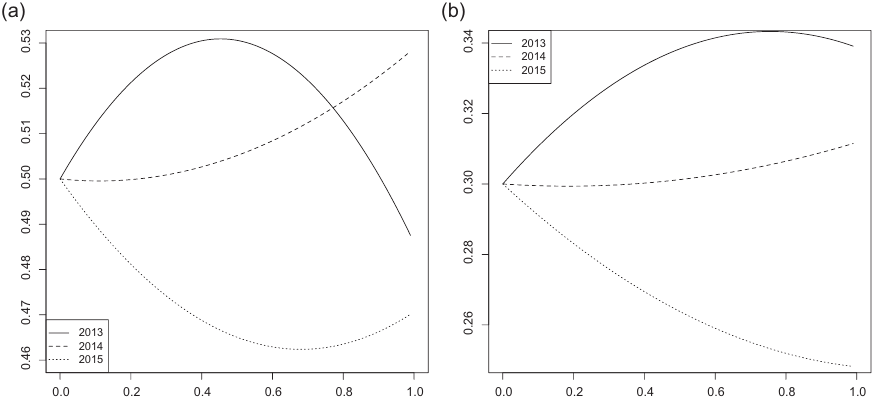
^ Figure 4. P ð U > u 0 j V > v Þ according to equation (2), for v 2 ½ 0 ; 1 (cid:3) : (a) u 0 = 0.5, years: 2013, 2014 and 2015. (b) u 0 = 0.7, years: 2013, 2014 and